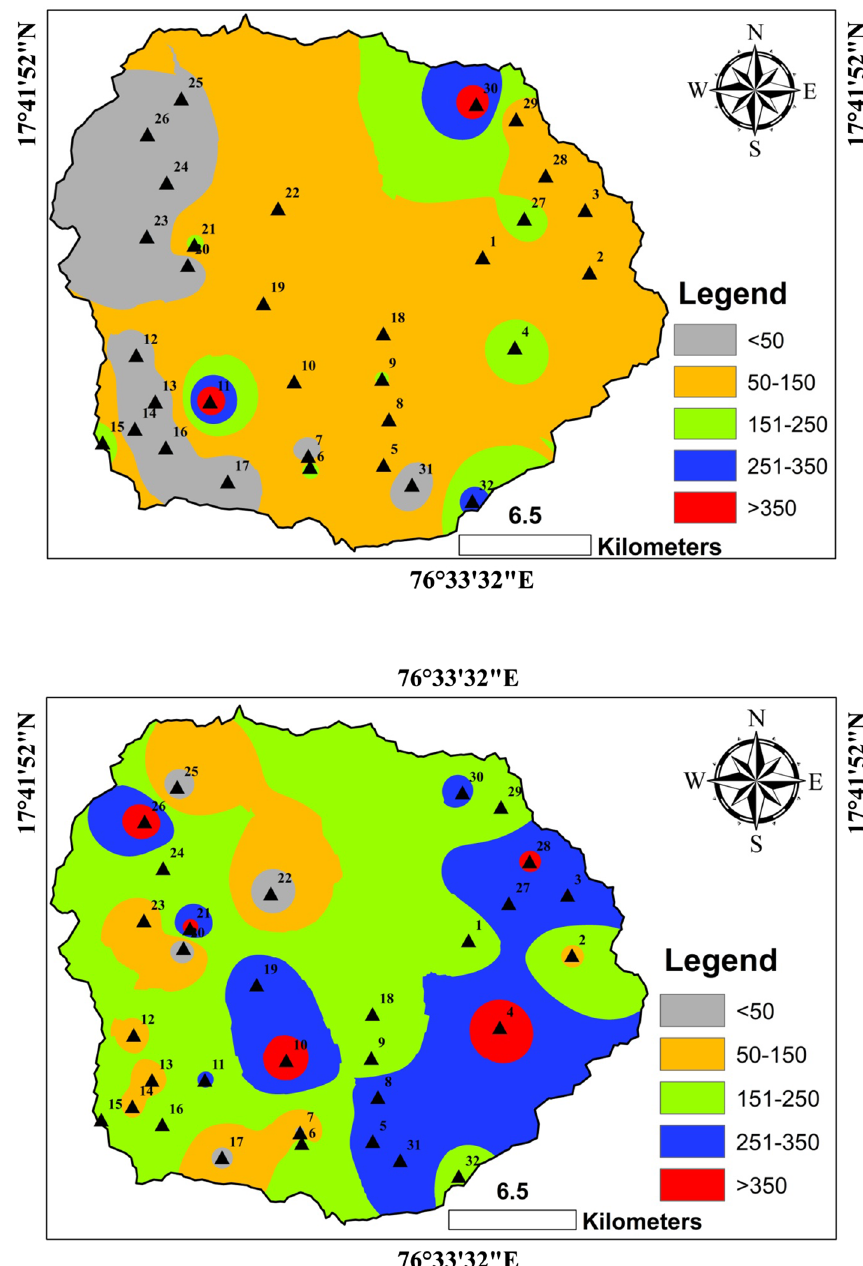
Fig. 30 Geospatial distribution of hardness (pre-monsoon)